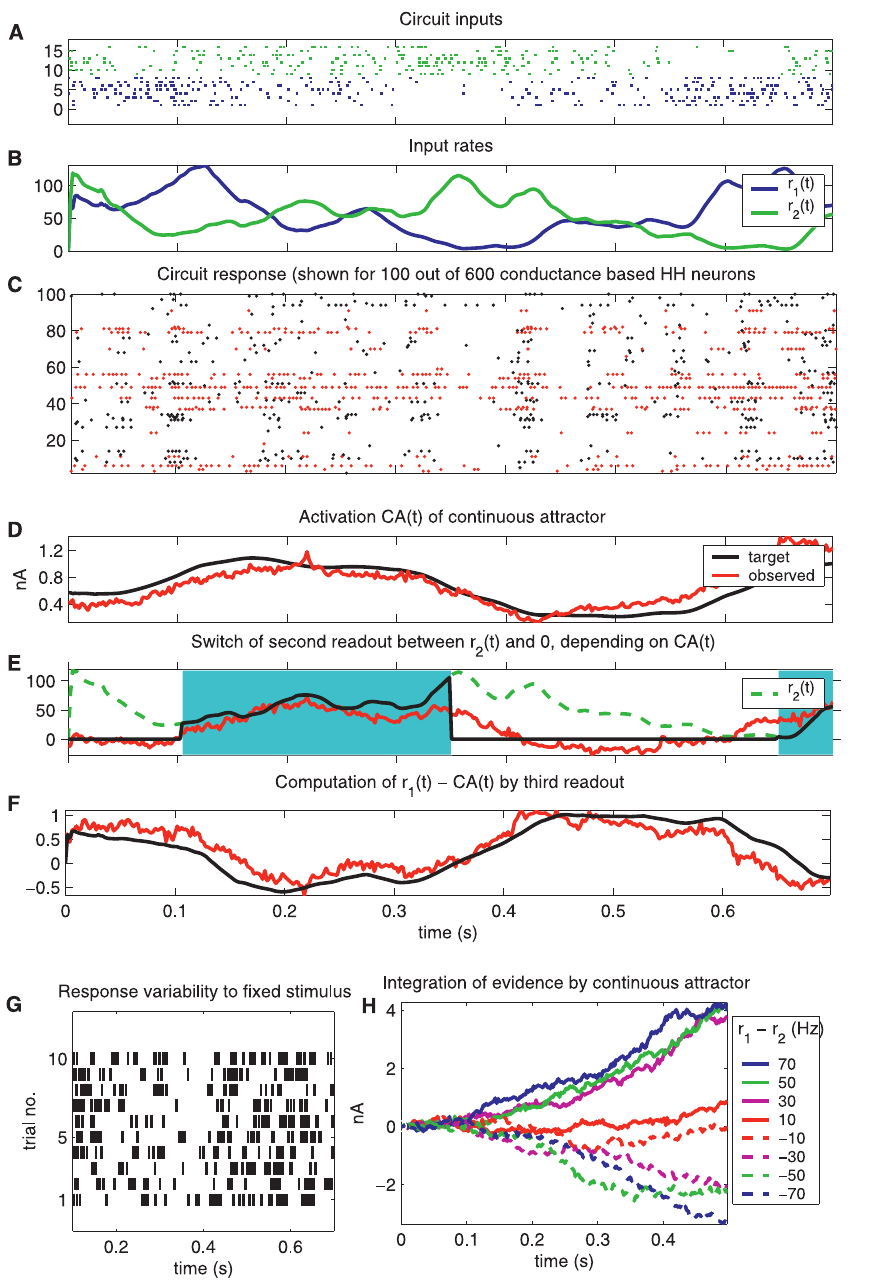
Figure 4. A Model for Analog Real-Time Computation on External and Internal Variables in a Generic Cortical Microcircuit (Consisting of 600 Conductance-Based HH Neurons) (A,B) Two input streams as in Figure 2. (B) Their firing rates r 1 ( t ), r 2 ( t ). (C) Resulting firing activity of 100 neurons in the circuit. (D) Performance of a neural integrator, generated by feedback from a linear readout that was trained to output at any time t an approximation CA ( t ) of the integral R t ð r 1 ð s Þ (cid:2) r 2 ð s ÞÞ ds over the difference of both input rates. Feedback values were injected as input currents into a randomly chosen subset 0 of neurons in the circuit. Scale in nA shows average strength of feedback currents, also in (H). (E) Performance of linear readout that was trained to output 0 as long as CA ( t ) stayed below 0.83 nA, and to output r 2 ( t ) once CA ( t ) had crossed this threshold, as long as CA ( t ) stayed above 0.66 nA (i.e., in this test run during the shaded time periods). (F) Performance of linear readout trained to output r 1 ( t ) (cid:2) CA ( t ), i.e., a combination of external and internal variables, at any time t (both r 1 and CA normalized into the range [0,1]). (G) Response of a randomly chosen neuron in the circuit for ten repetitions of the same experiment (with input spike trains generated by Poisson processes with the same time course of firing rates), showing biologically realistic trial-to-trial variability. (H) Activity traces of a continuous attractor as in (D), but in eight different trials for eight different fixed values of r 1 and r 2 (shown on the right).